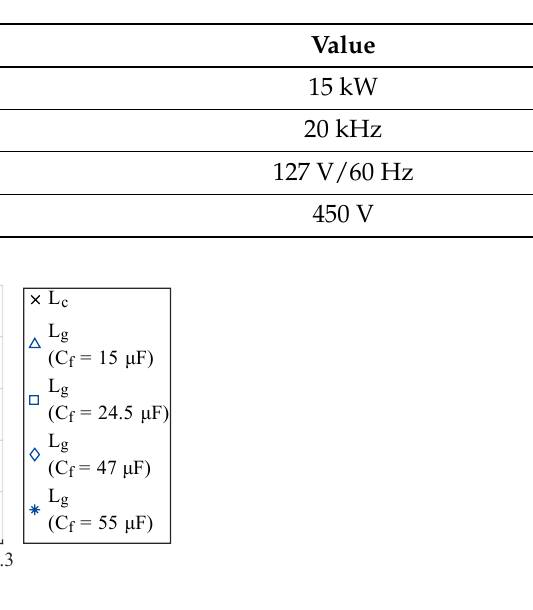
/ I c , lf , for different C f s